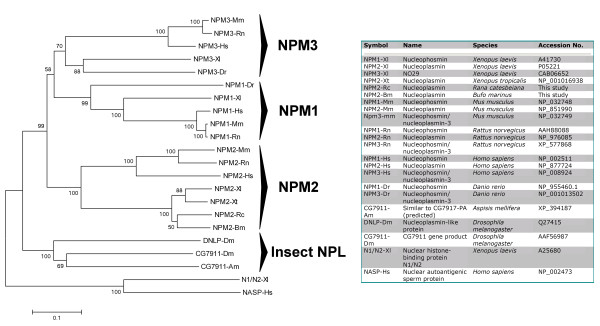
Phylogenetic tree of nucleophosmin/nucleoplasmin family members from various metazoans. Amino acid sequences were aligned with CLUSTAL W (Thompson et al., 1994), and the tree was produced with MEGA 3.1 (Kumar et al., 2004) using the neighbor-joining method. Two other histone-binding proteins, NASP [61] and N1/N2 [62], which are closely related to each other [61] but unrelated to the nucleophosmin/nucleoplasmin family were used to root the tree. Bootstrap significance values are shown at the corresponding internal nodes after 1000 replications.